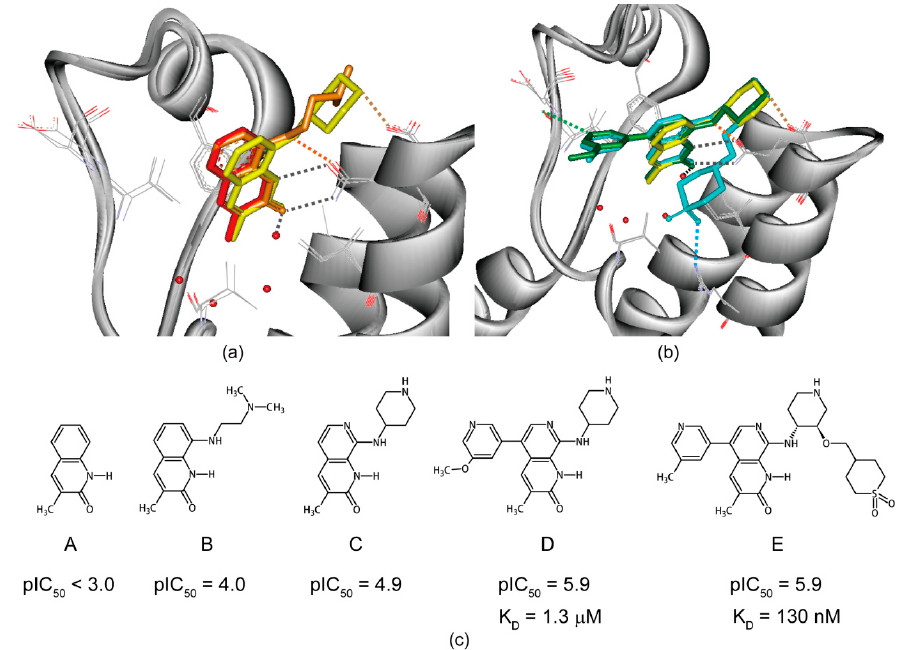
Figure 3. Hit-to-lead evolution in the discovery of ATAD2 bromodomain inhibitors. ( a ) Superimposition of the ATAD2 bromodomains in complex with fragment screening hits and derived analogues; ( b ) Structure-guided evolution from a micromolar affinity led to a nanomolar potent inhibitor; ( c ) Chemical structures of ATAD2 bromodomain inhibitors with their activities annotated. Compounds A–E are colored in red, orange, yellow, green, and cyan in ( a , b ), with PDB codes 5A5O , 5A5P , 5A5Q , 5A5R and 5A83 , respectively. The pIC 50 and K D values are measured using TR-FRET (time-resolved fluorescence resonance energy transfer) and SPR (surface plasmon resonance), respectively [103,104].